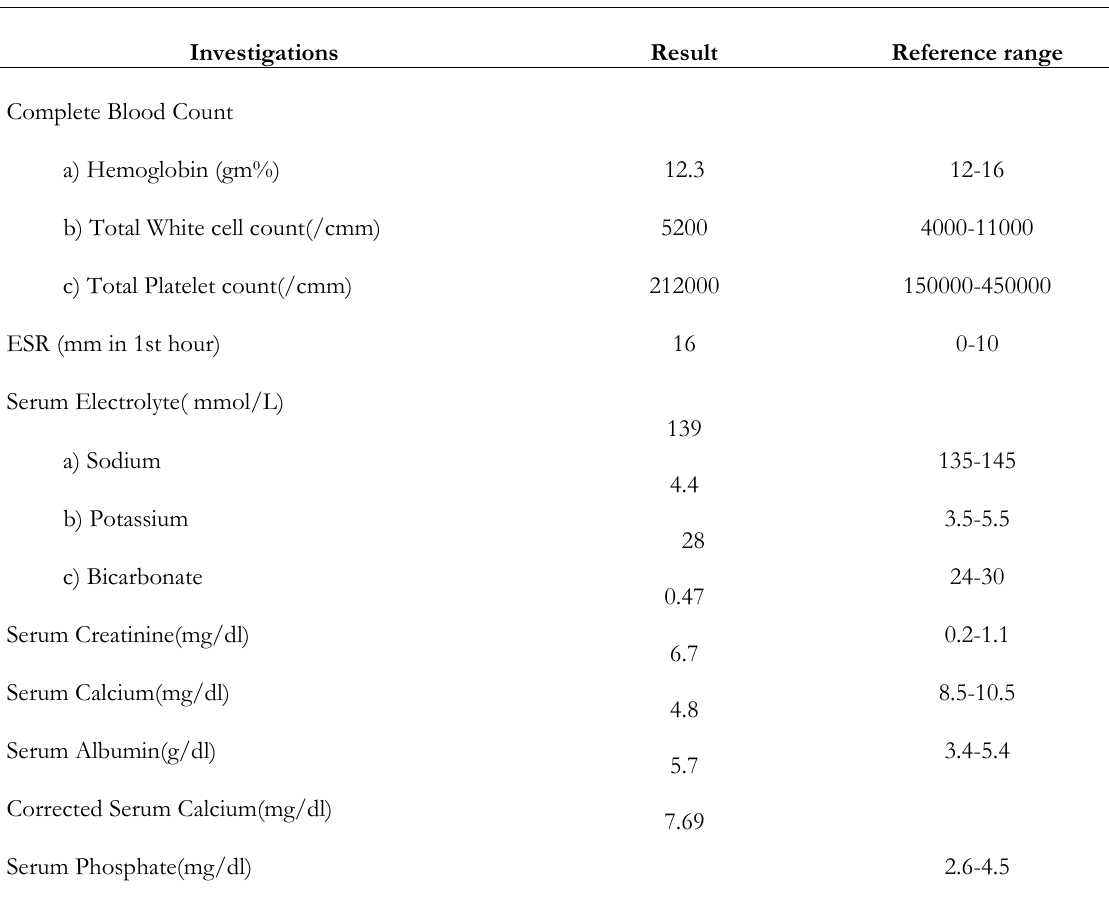
Table 1: Laboratory